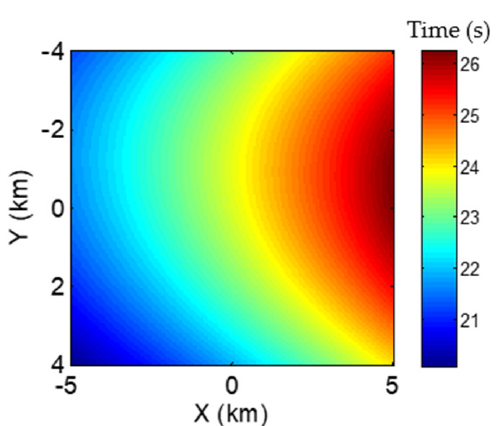
Figure 11. Integration time simulation result of CF-SAR.